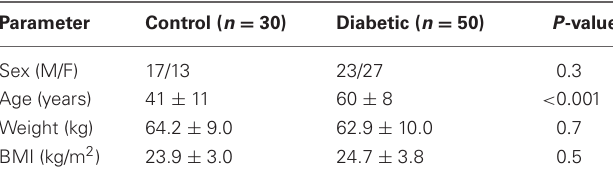
Table 2 | Anthropometric